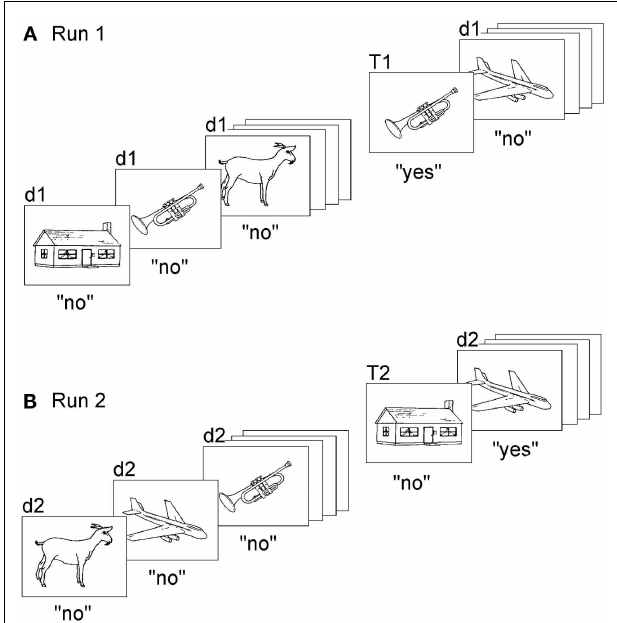
FIGURE 2 |Task to measure the sense of present reality . Subjects make two runs (or more) of a continuous recognition task, each run composed of the same set of pictures. Subjects have to indicate, in both runs, only repetitions within the ongoing run (original version: Schnider et al., 1996a). (A) The first run demands learning and recognition and can be solved on the basis of familiarity alone. (B) In the second run, all items are already familiar. The task now demands the ability to distinguish between memories that pertain to the ongoing run (repetitions within the run,T2) and memories that do not (d2; not previously presented within the run, albeit familiar from the first run). Confabulating patients had a steep increase of false positives in response to d2 stimuli. “d” denotes “distracters,” i.e., pictures’ first appearance within a run; “T” denotes targets, i.e., repeated pictures within the run. “d1” and “T1” are stimuli presented in the first run, “d2” and “T2” are stimuli of the second run. “Yes” and “no” indicate correct responses. Illustration reproduced from Schnider (2008), with